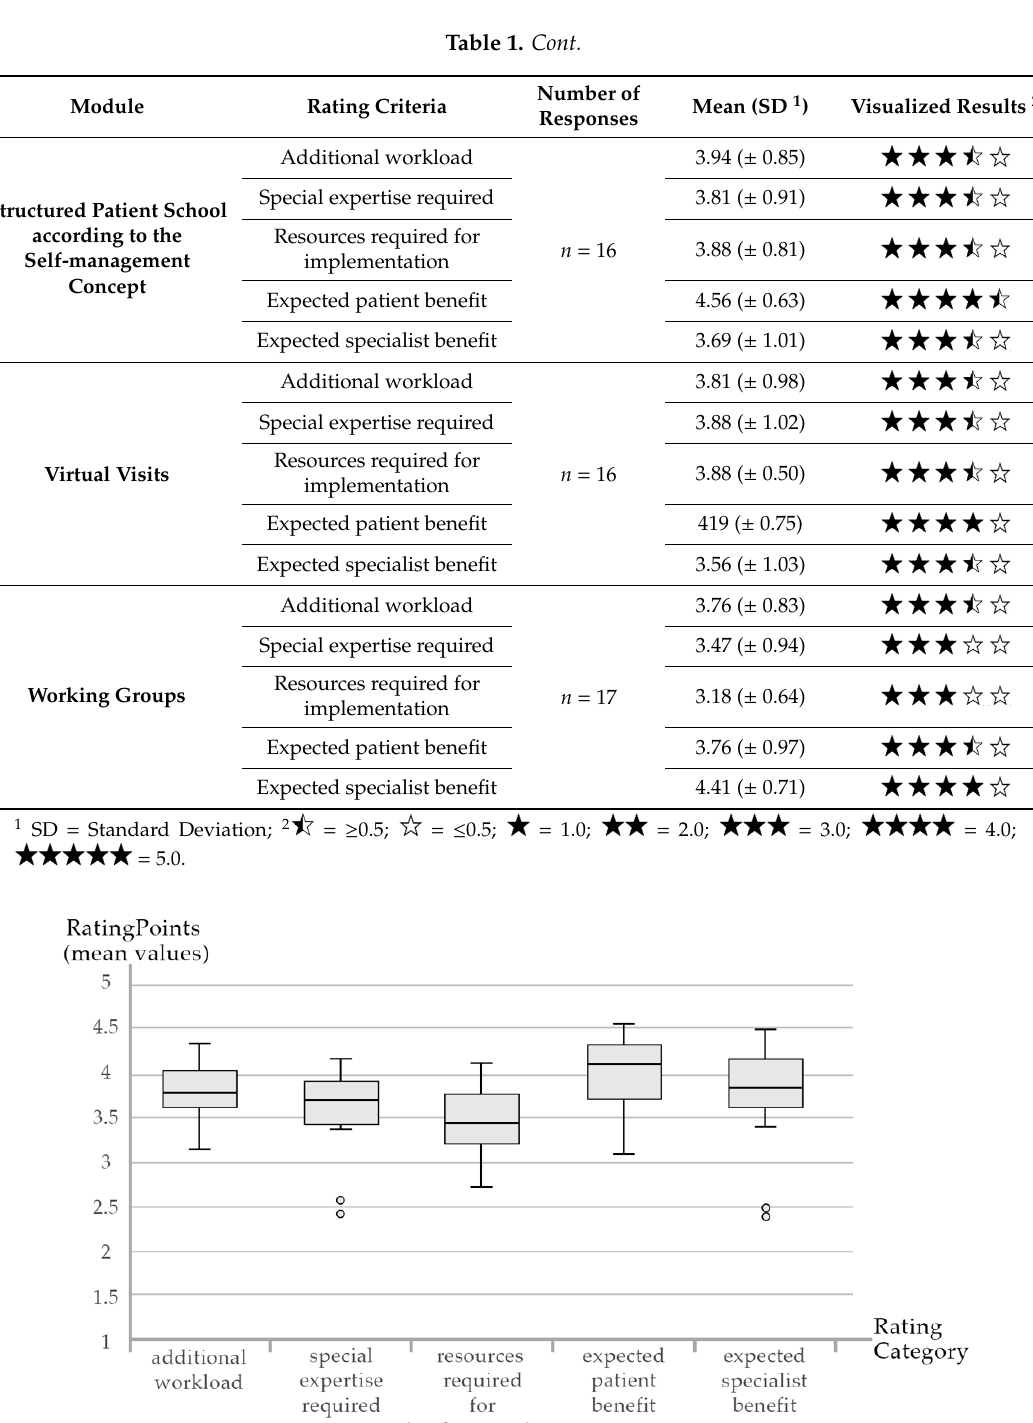
Figure 3. Box Plots for the Rating Categories and Rating Values (Modules: n = 25, Raters: n = 17) . Table 1. Expert Rating for German Parkinson Network Modules .